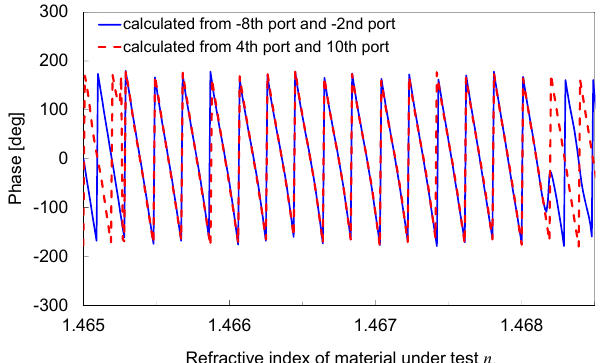
/ –2nd port and 4th port / 10th port as a function of n